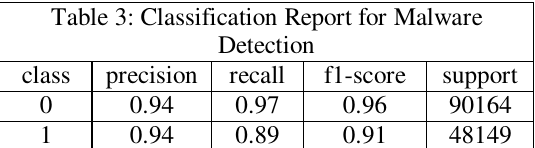
Table 3: Classification Report for Malware